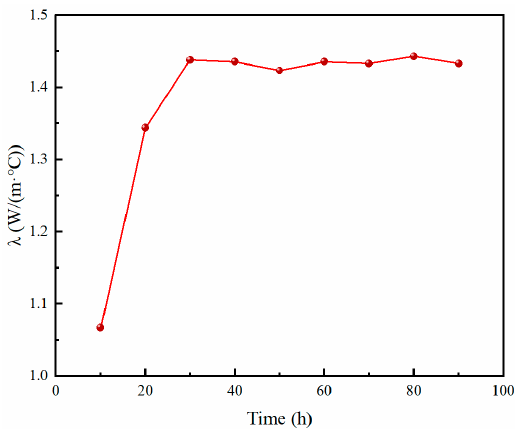
Figure 9. Effects of test duration on thermal conductivity of CPB.